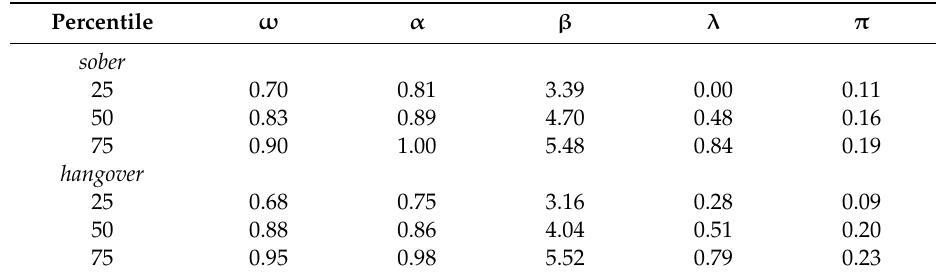
Table 3. Distribution of estimated parameters based on the hybrid dual-system reinforcement-learning model for the sober and hangover